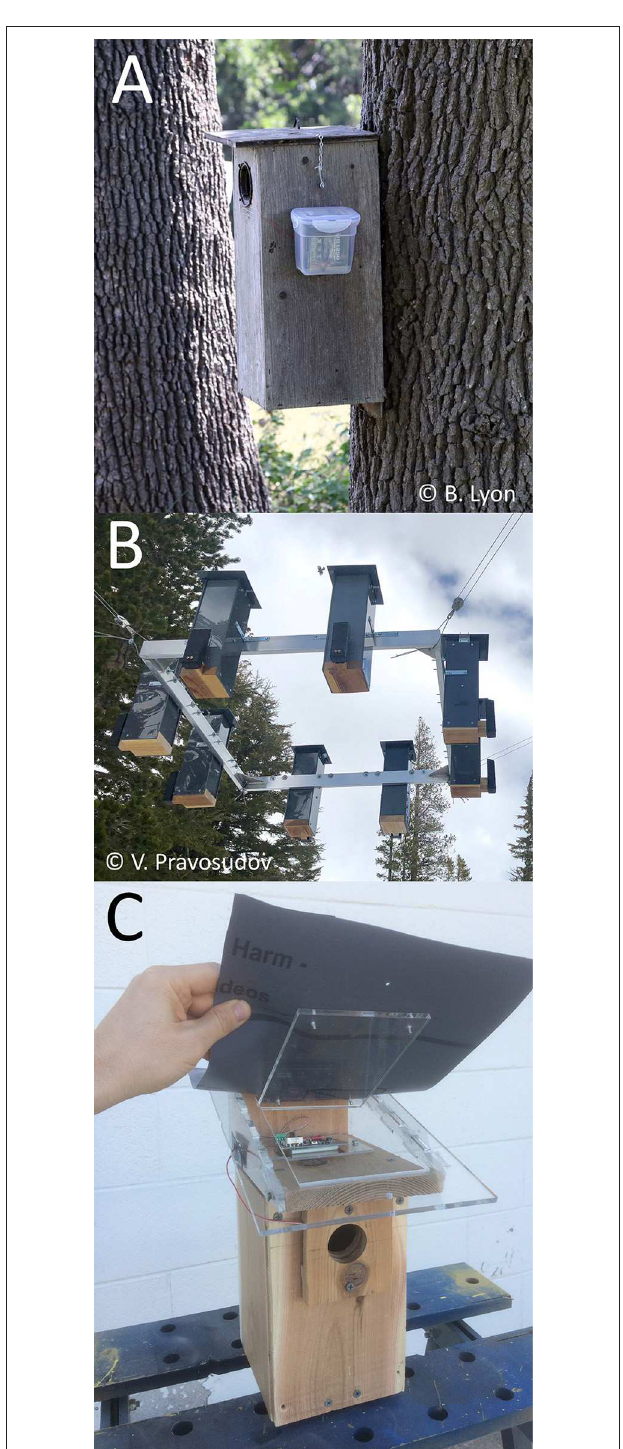
FIGURE 2 | (A) RFID-equipped Wood Duck nest box deployed near Davis California. RFID reader and battery are housed in a water-tight plastic box attached to the side of the box (painted in camouflage at other installations). The hand-wrapped and tuned antenna was coated in plasti-dip and secured around the nest entrance hole with zip ties. The antenna leads connect to the